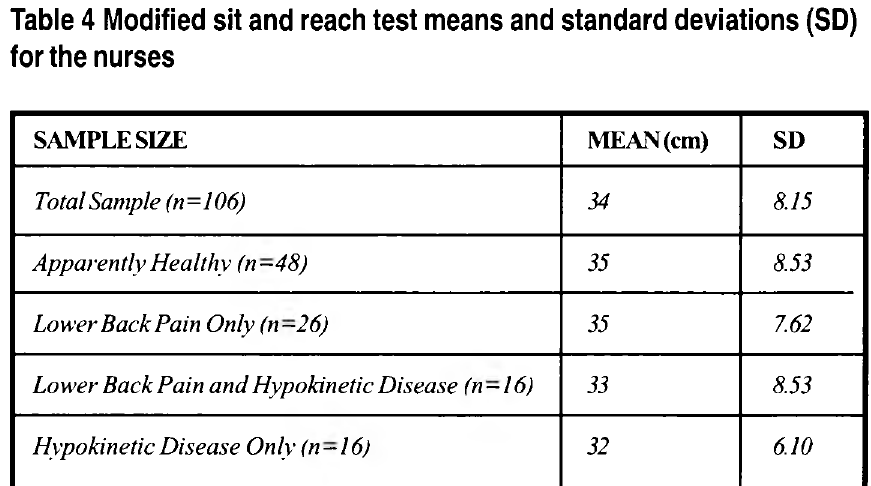
Table 4 Modified sit and reach test means and standard deviations (SD)